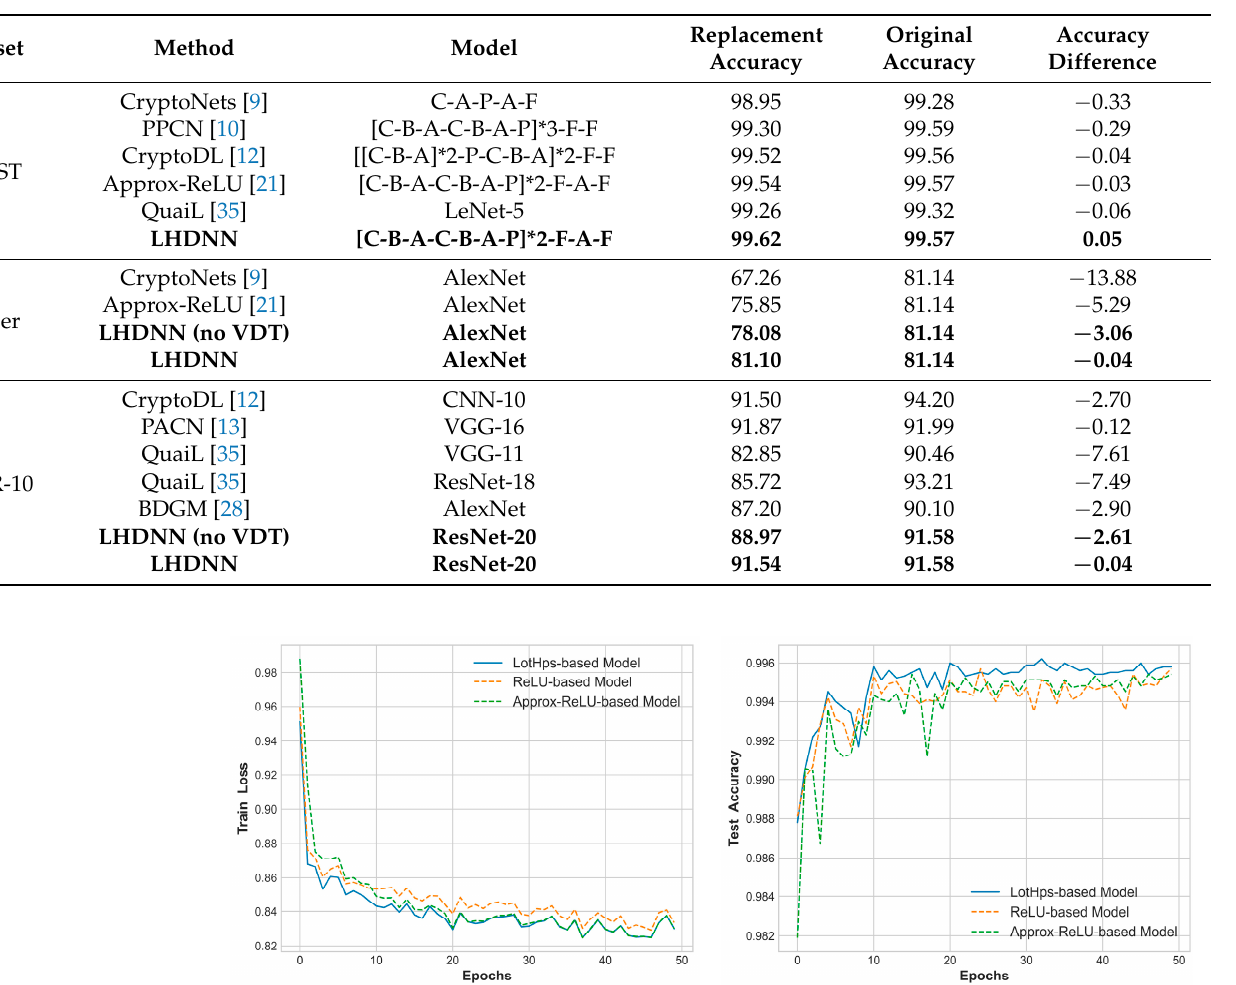
Table 4. Contrast of plaintext accuracy on three datasets.